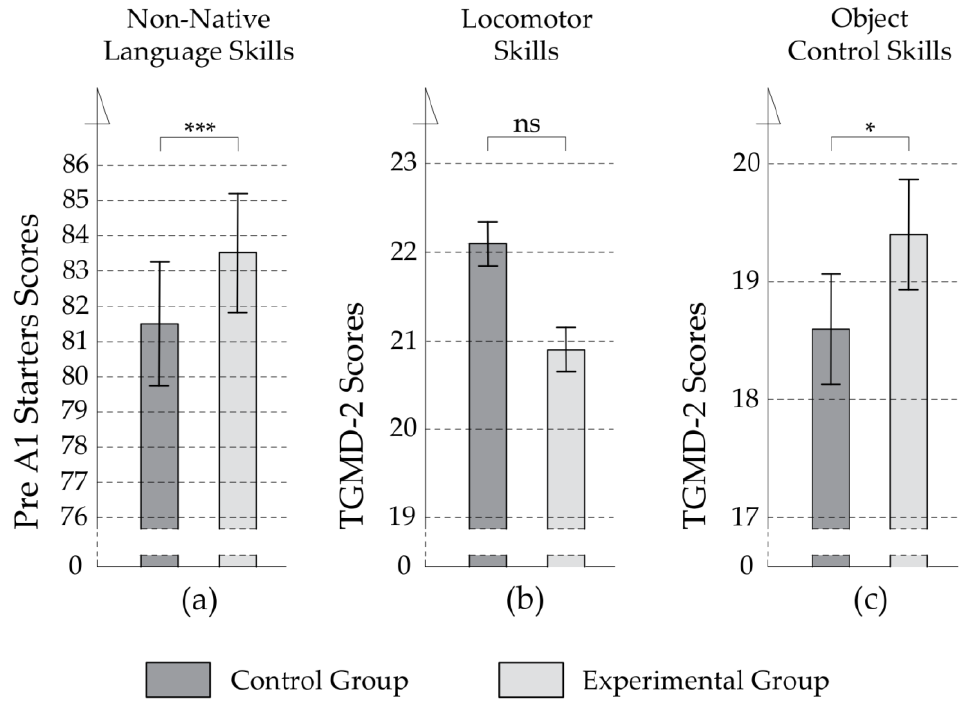
Figure 3. Results of the experiment in terms of non-native language and motor skills divided into two groups (non-Eduball vs. Eduball) and expressed as estimated marginal means. ( a ) The results of the two groups non-native language skills (%); ( b ) the results of the two groups in total locomotor skills; ( c ) the results of the two groups in total object control skills. Asterisks indicate significant p -values: * p < 0.05, *** p < 0.001 (ns—not significant). Error bars depict standard errors of the means.